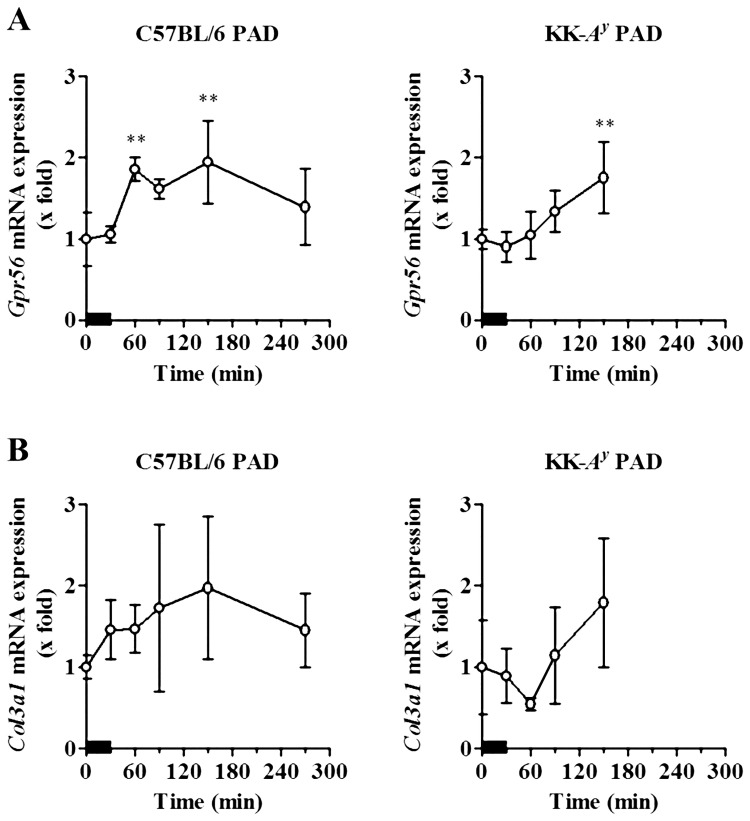
Acute effects of treadmill exercise on the mRNA expression of Gpr56 and its ligand, Col3a1.The soleus muscles of exercised C57BL/6 PAD mice (left) and KK-Ay PAD mice (right) were obtained and the mRNA expression levels of Gpr56 (A) and Col3a1 (B) in the soleus muscles were determined, normalized, and calculated as described in the legend of Fig 2. The results are expressed as the mean ± SD. **p < 0.01 vs. 0 min (Dunnett’s test). Bold bars represent timing of the fifth treadmill exercise.